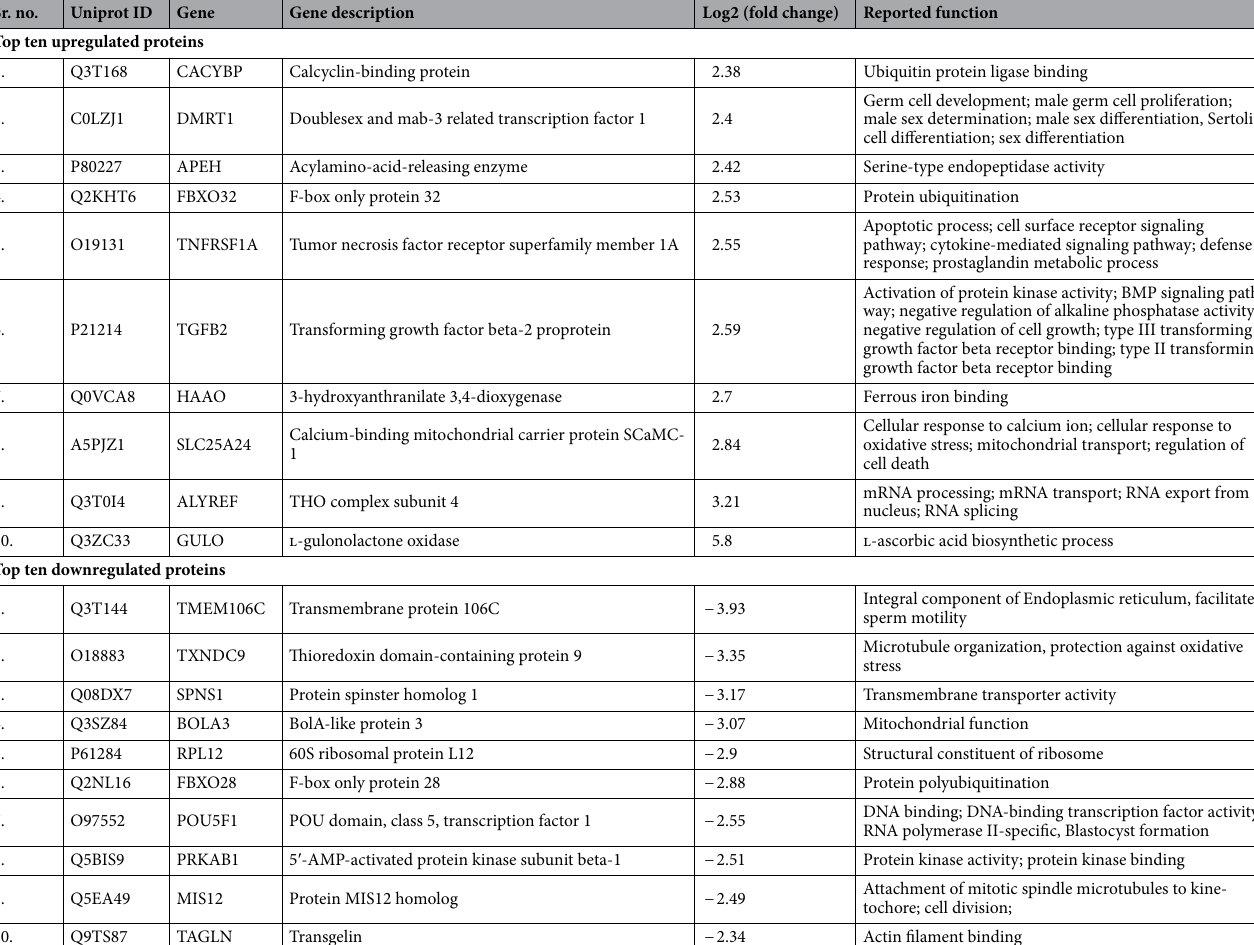
Table 2. Top 10 upregulated and down regulated proteins in low-fertility